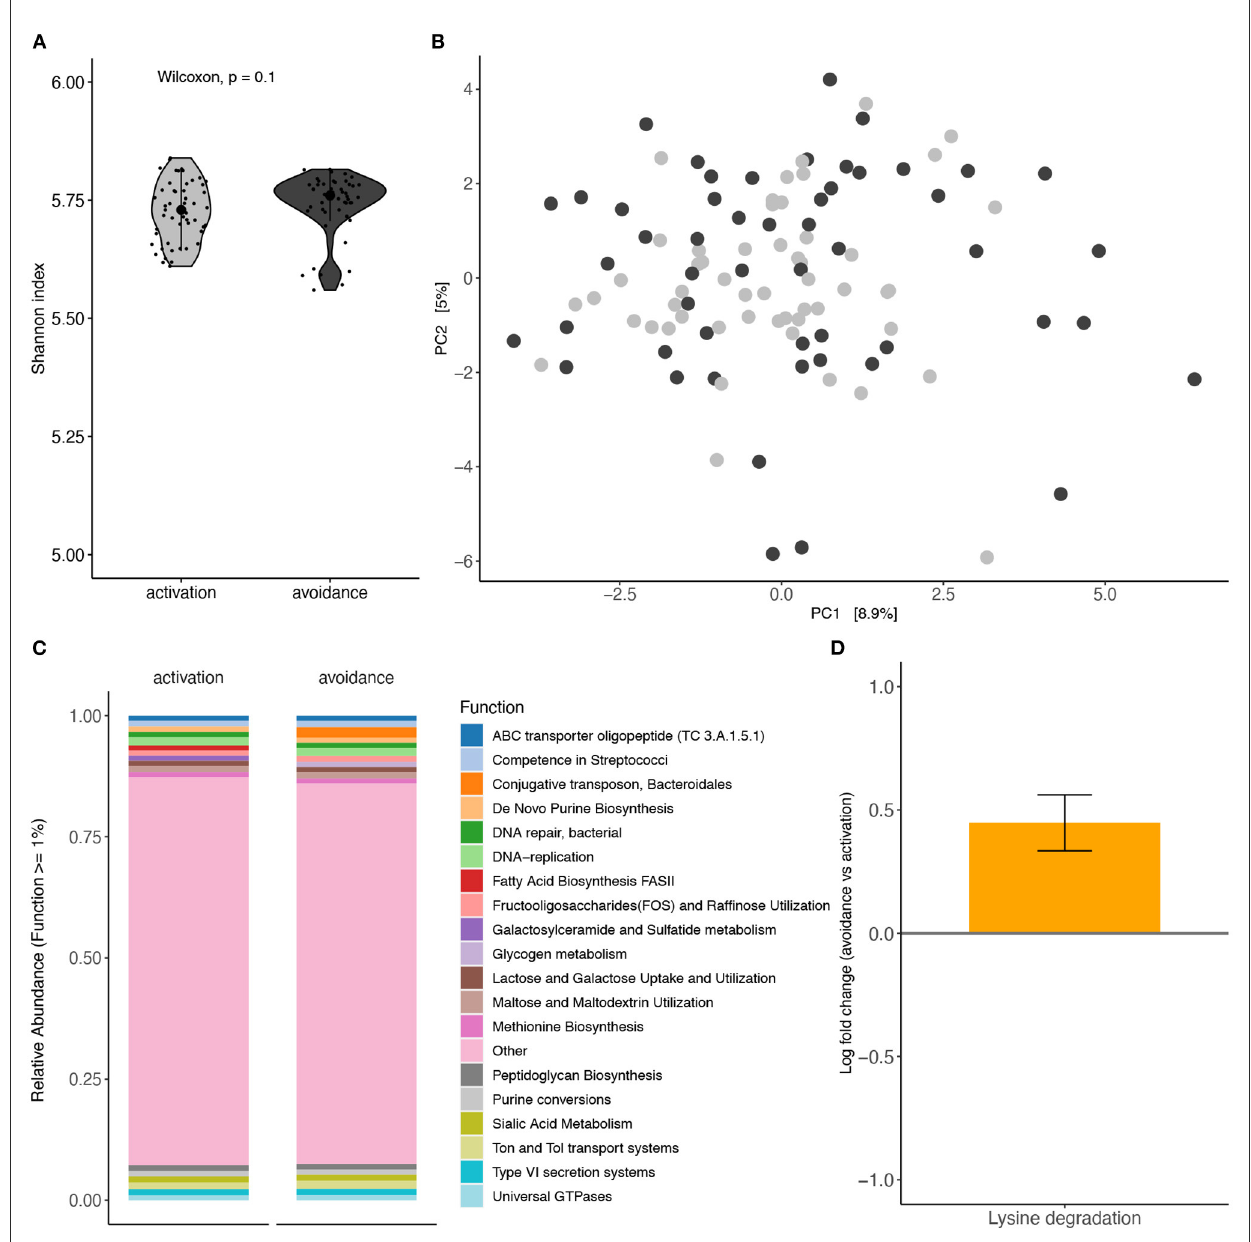
FIGURE4 Functional profiling analysis of oral microbiota based on BADS. Functional profiling between BADS avoidance and activation groups (A) alpha diversity (Shannon index) and (B) beta diversity (Aitchison distance). (C) Average functional profiles with an abundance > 1% are shown. (D) Lysine degradations different abundance between the two conditions (ANCOM-BC, q =